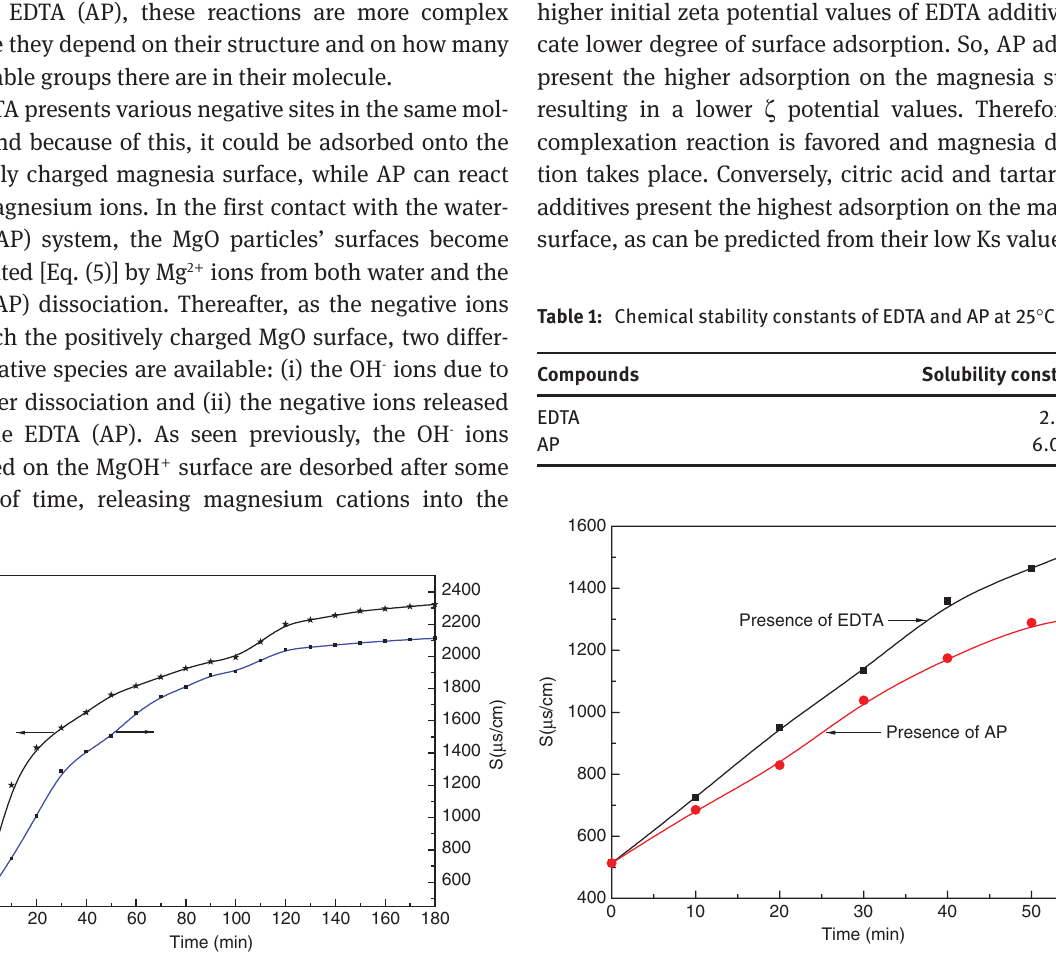
Figure 4: Change of electrical conductivity of MgO slurry treated by AP or EDTA with